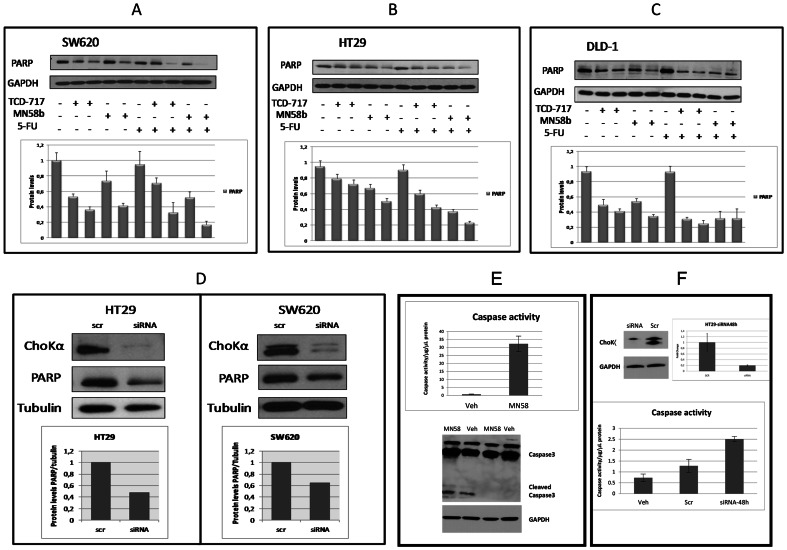
Induction of apoptosis in SW620, HT29 and DLD-1 cell lines after treatment with ChoKIs.(A–C) SW620, HT29 and DLD-1 cells were seeded as described under Material and Methods and treated with two concentrations of ChoKα inhibitors [TCD-717: 6 µM (left line) or 10 µM (right line); MN58b: 10 µM (left line) or 15 µM (right line)] for 24 h and, where indicated, with 5.5 µM 5-FU or vehicle for an additional 24 h. Protein expression was analyzed by Western blot using polyclonal antibody anti-PARP. Behind each graph, data shows protein levels (PARP/GAPDH) calculated by the mean ± SEM of three independent experiments. (A) SW620. (B) HT29. (C) DLD-1. (D) PARP and ChoKα expression levels in HT29 and SW620 cell lines transfected with a specific ChoKα siRNA determined by Western blot analysis or a control scramble siRNA (scr). Protein expression was analyzed by Western blot using ChoKα monoclonal antibody and polyclonal antibody anti-PARP. Below each Western the ratio PARP/Tubulin is represented. (E) Caspase 3 activity (upper panel) and its cleavage (lower panel) were determined in HT29 cells after treatment with MN58b for 24 h. (F) Caspase 3 enzymatic activity was also measured after transfection of HT29 cells with a ChoKα specific siRNA or a control siRNA (scr) for 48 h. Western blot represents the levels of ChoKα after transfection and its relative reduction normalized to GAPDH levels.